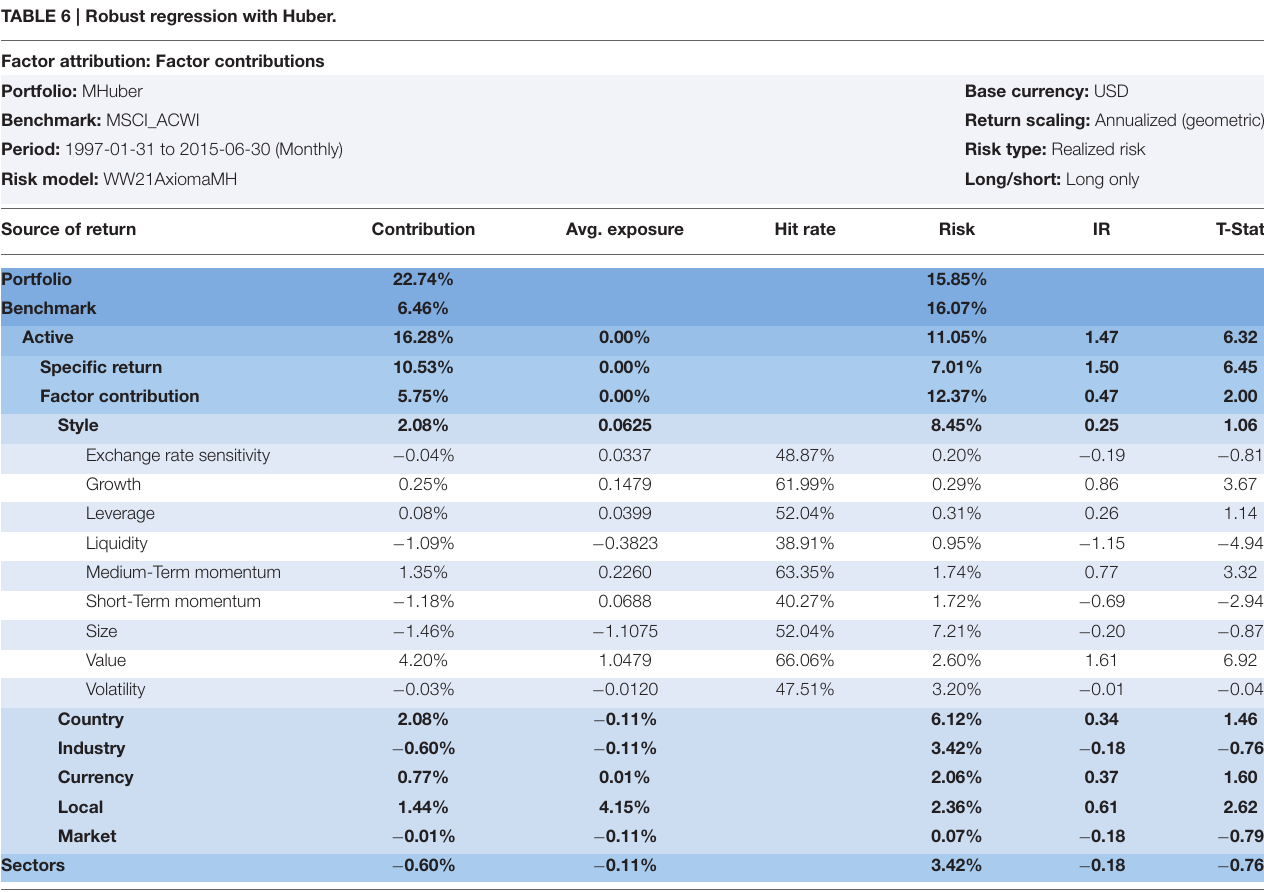
TABLE 6 | Robust regression with